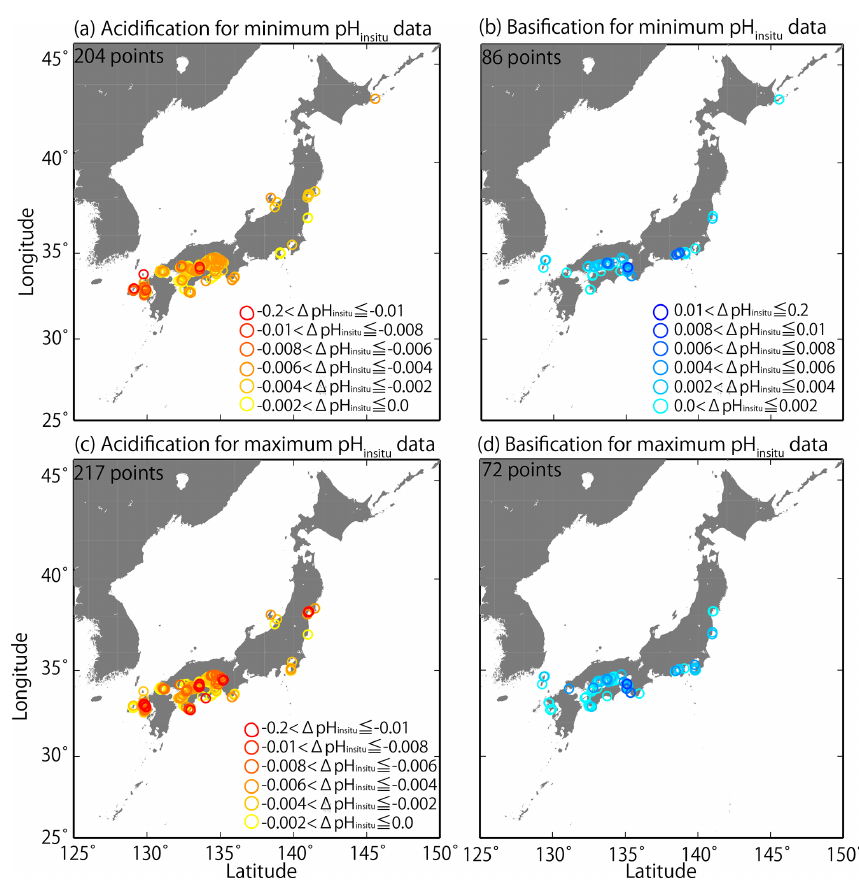
Figure 8. Distributions of long-term trends in pH insitu ( (cid:49) pH insitu yr − 1 ) in Japanese coastal seawater. The colors indicate the ranges of acidification (a, c) and basification (b, d) . Panels (a, b) and (c, d) are linked to the data used in Fig. 7e and f,